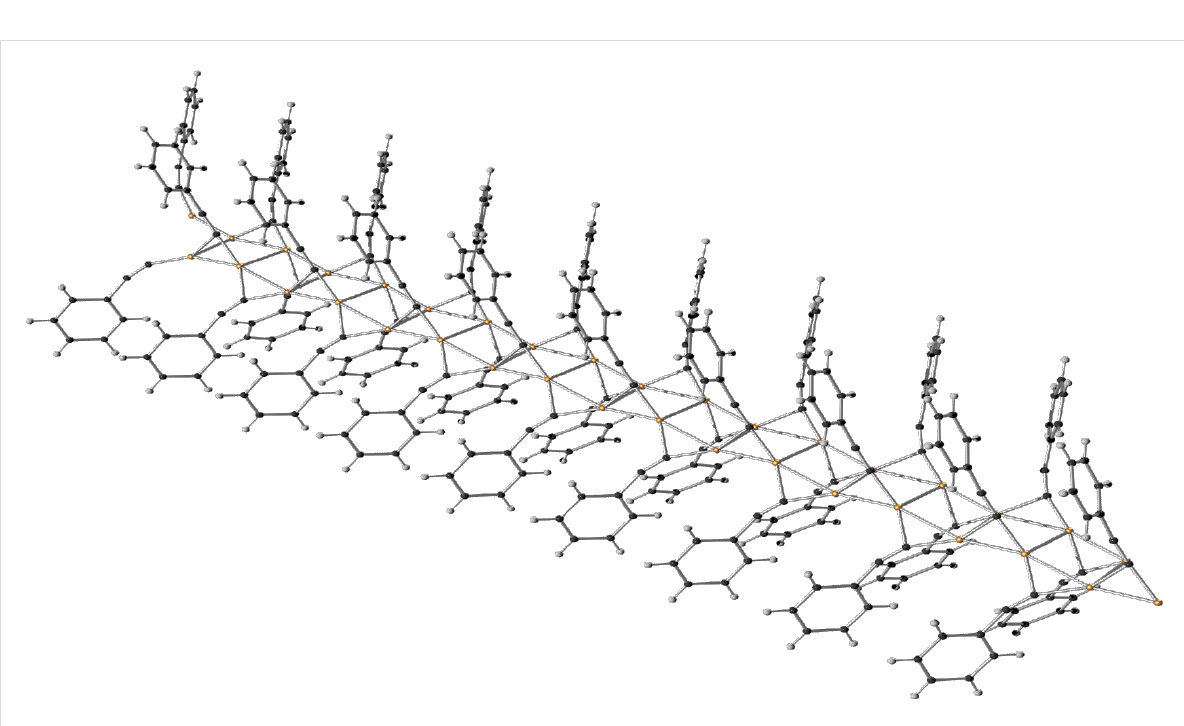
Figure 10: ORTEP plot [202,203] of the X-ray powder diffraction crystal structure of (phenylethynyl)copper(I) [(PhC ≡ CCu) 2 ] n by Che et al. [184,204].